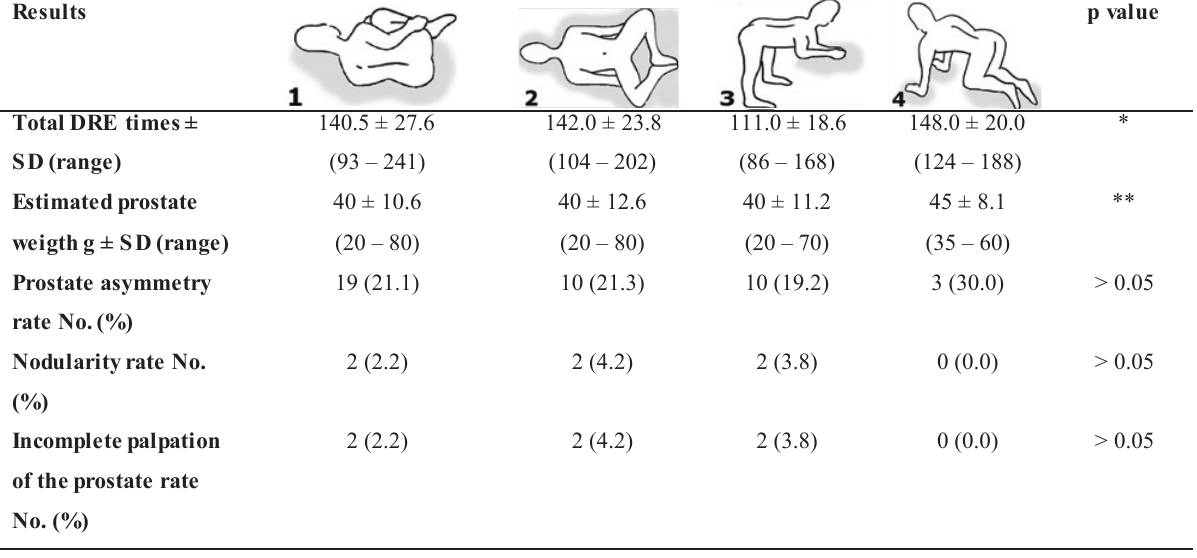
Table 4 – Results of Table 4 - Results of DRE.